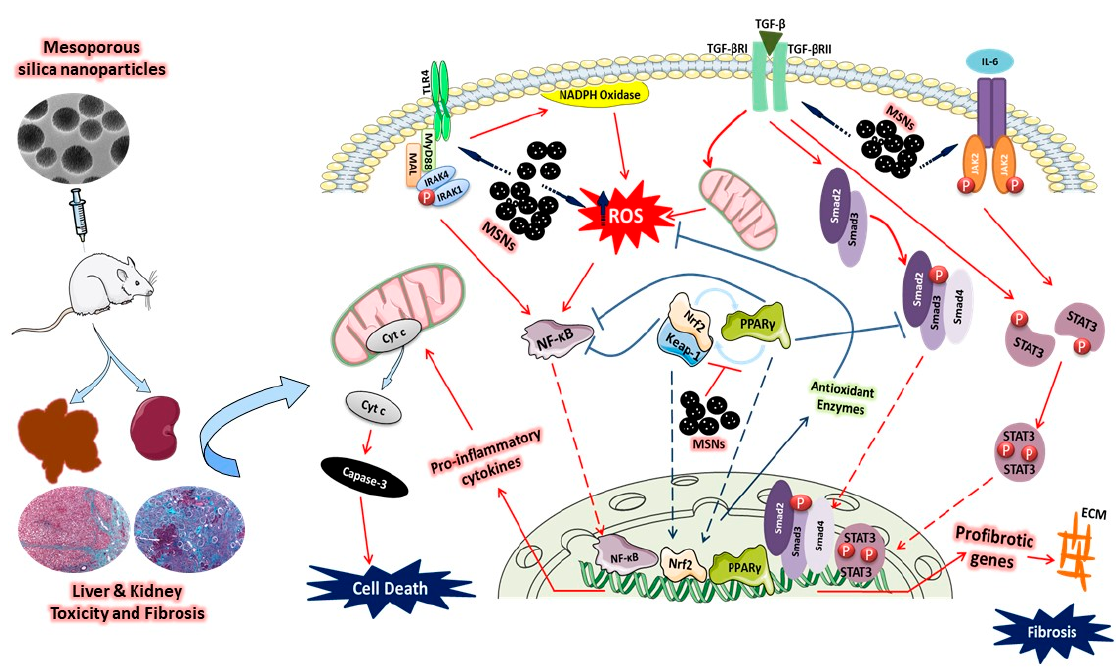
Figure 8. A proposed schematic diagram illustrating MSNs-induced hepatic and renal toxicity and fibrosis. MSNs provoke the production of ROS through the intrinsic production, mitochondrial dysfunction, and stimulation of NADPH oxidase, and activate the TLR4 / MyD88 signaling. ROS and elicited TLR4 / MyD88 signaling activates NF- κ B, and subsequently the release of pro-inflammatory cytokines, resulting in apoptotic cell death via activation of caspase-3. MSNs activate both TGF- β / Smad3 and JAK2 / STAT3 signaling, increase the transcription of profibrotic genes, and promote deposition of ECM and fibrosis. The increased ROS production, inflammation, and fibrosis induced by MSNs are augmented by the down-regulation of PPAR γ and Nrf2 / ARE / HO-1 signaling.